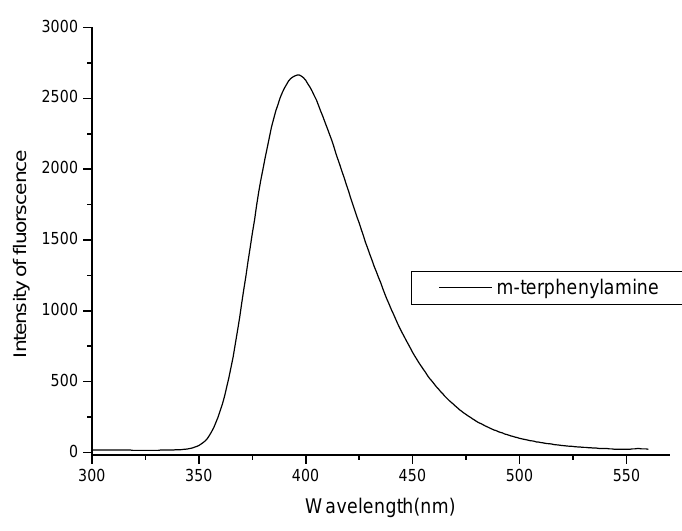
Figure 3. The PL spectra of m -terphenylamine.